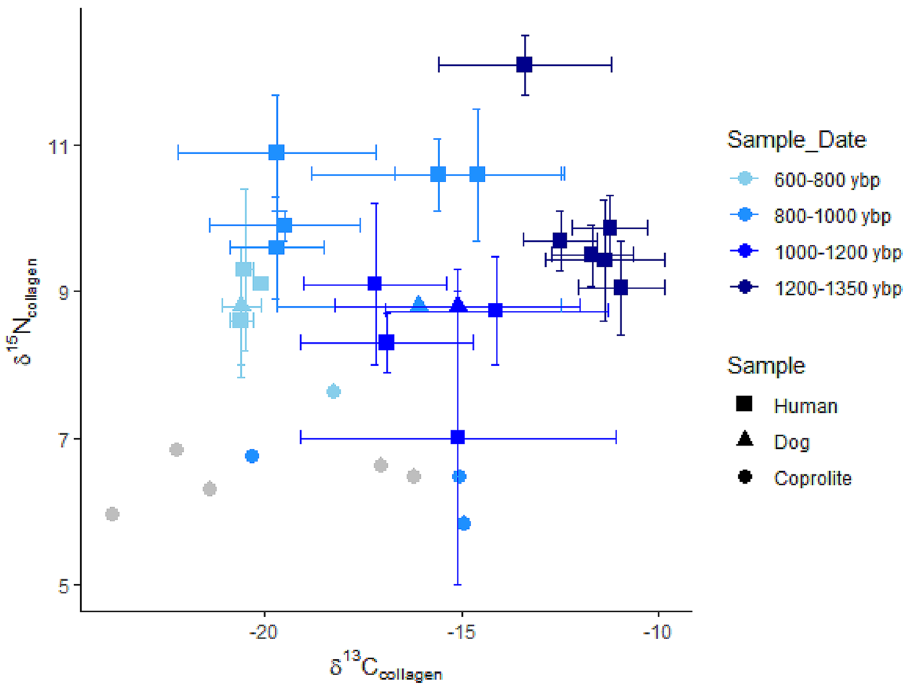
Figure 4. Coprolite δ 15 N and δ 13 C values, plotted in comparison to human and dog bone collagen values from Late Woodland and Mississippian populations in the American Bottom (data from Supplemental Table 6). Gray samples have an indeterminate age. Points lacking error bars reflect single individuals rather than populations. All coprolites are plotted individually (data from Table 2). This plot was created in R v. 4.0.2 111 using ggplot2 version 3.3.2 112